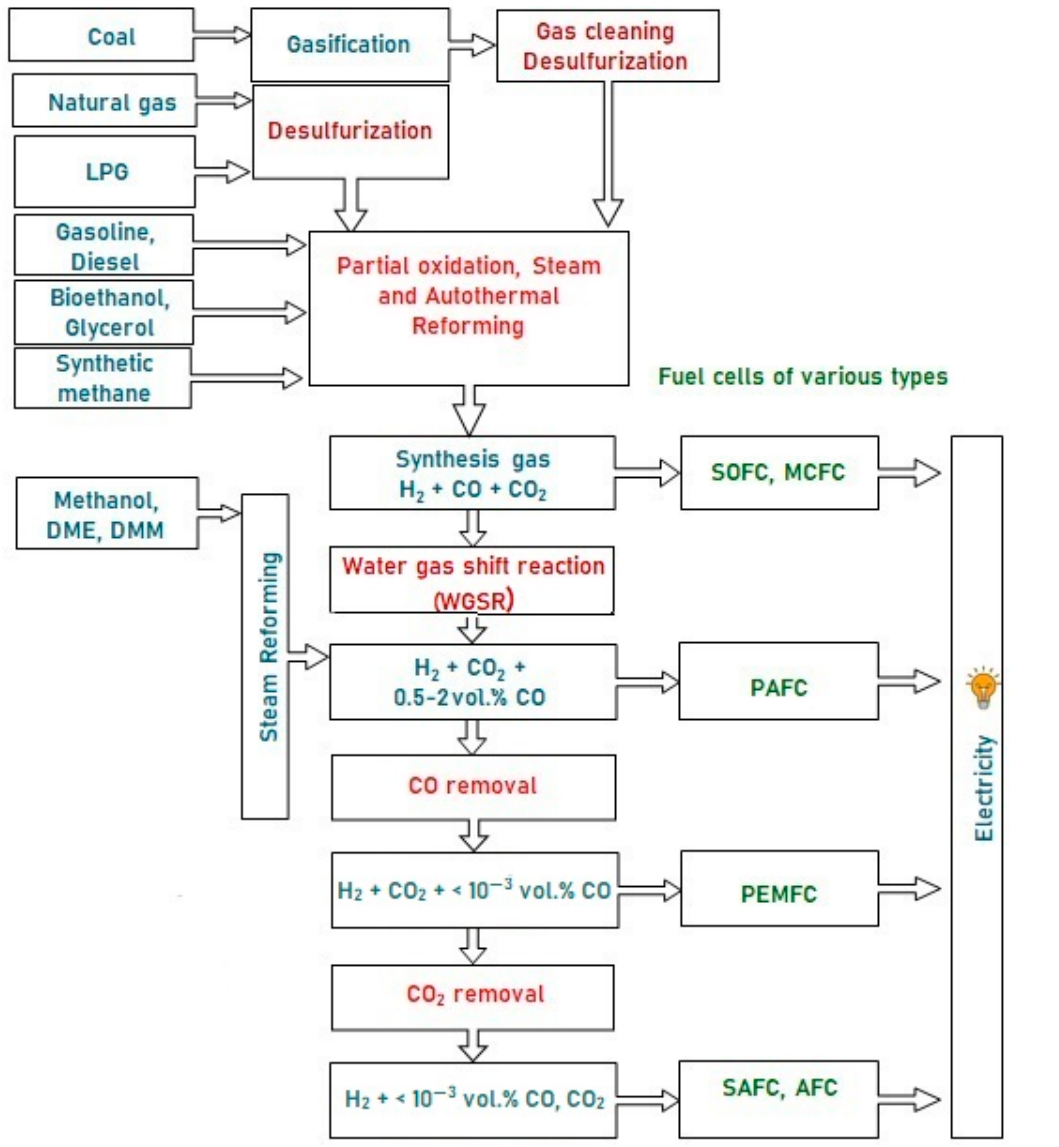
Figure 1. A typical scheme of hydrogen production from various fuels for feeding fuel cells of different types.